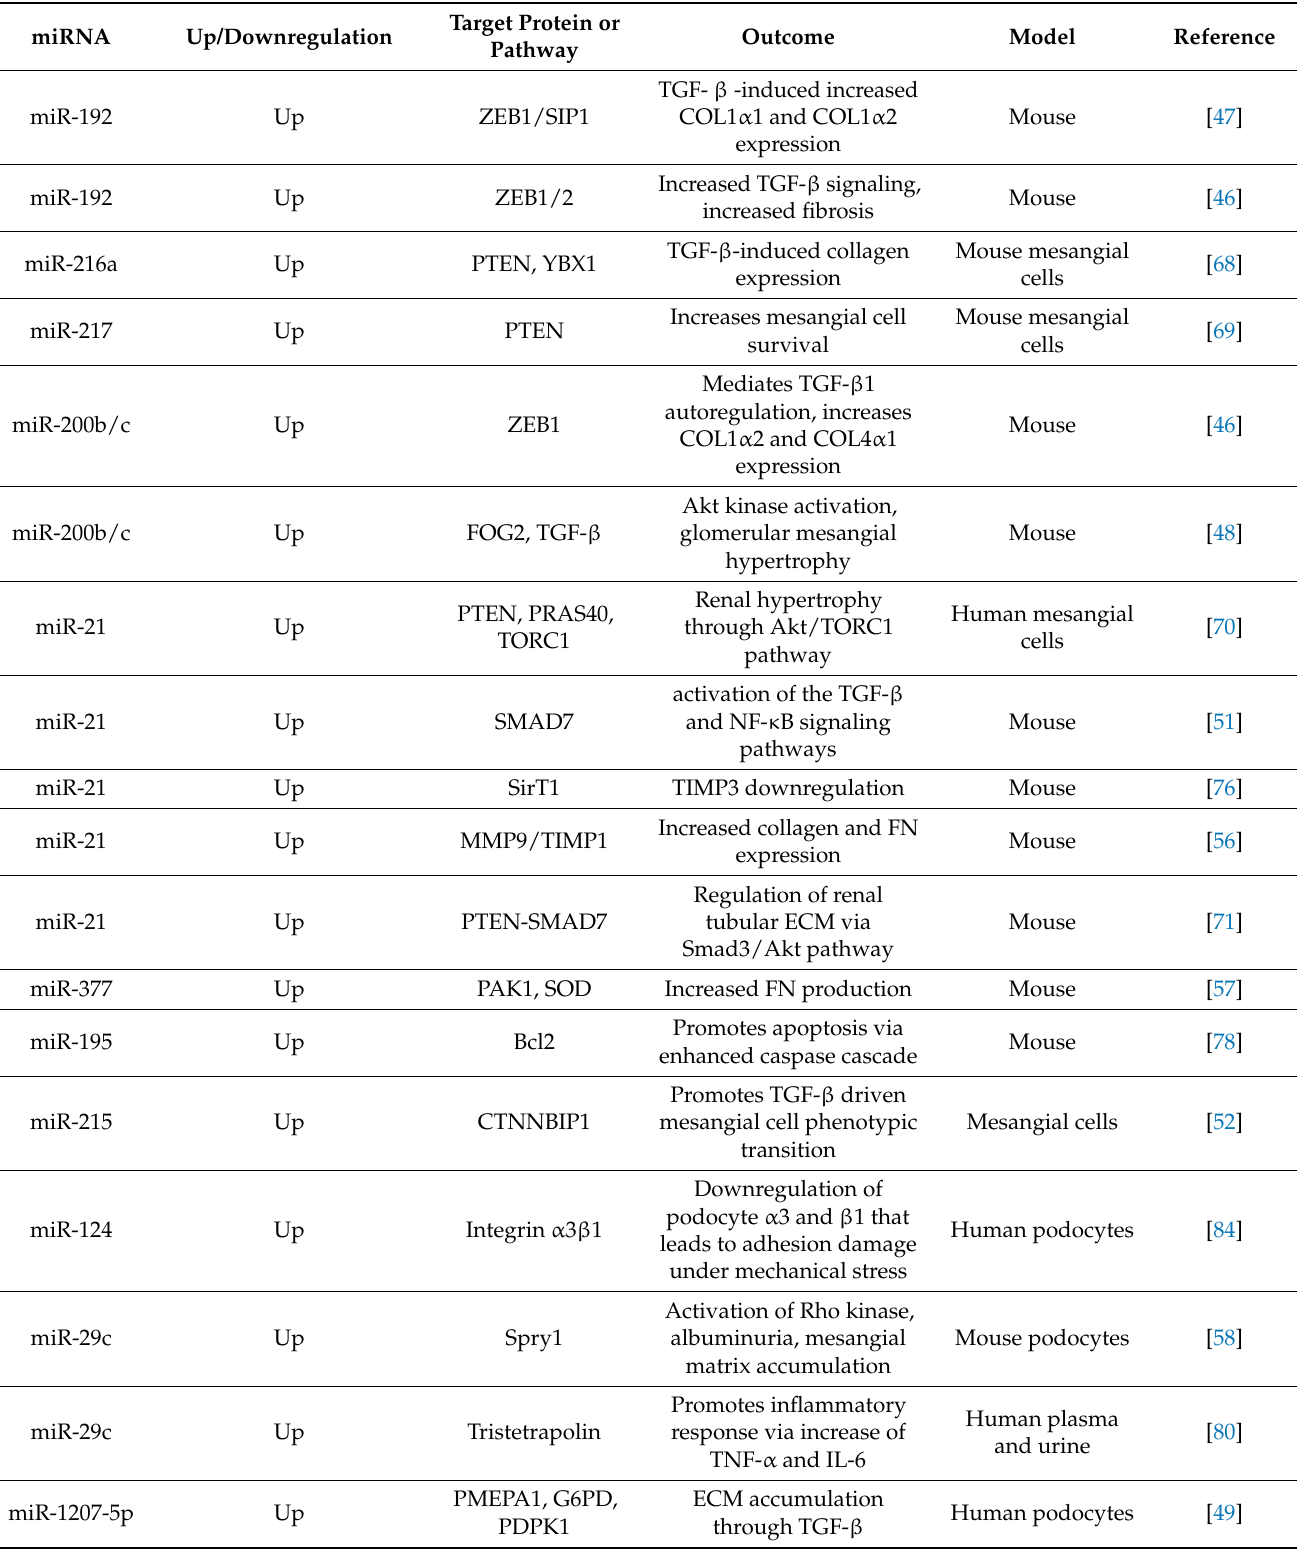
Table 1. Summarizing the effect of select microRNA on the pathogenesis of diabetic nephropathy with regard to target protein, type of regulation, outcome, and model used in the